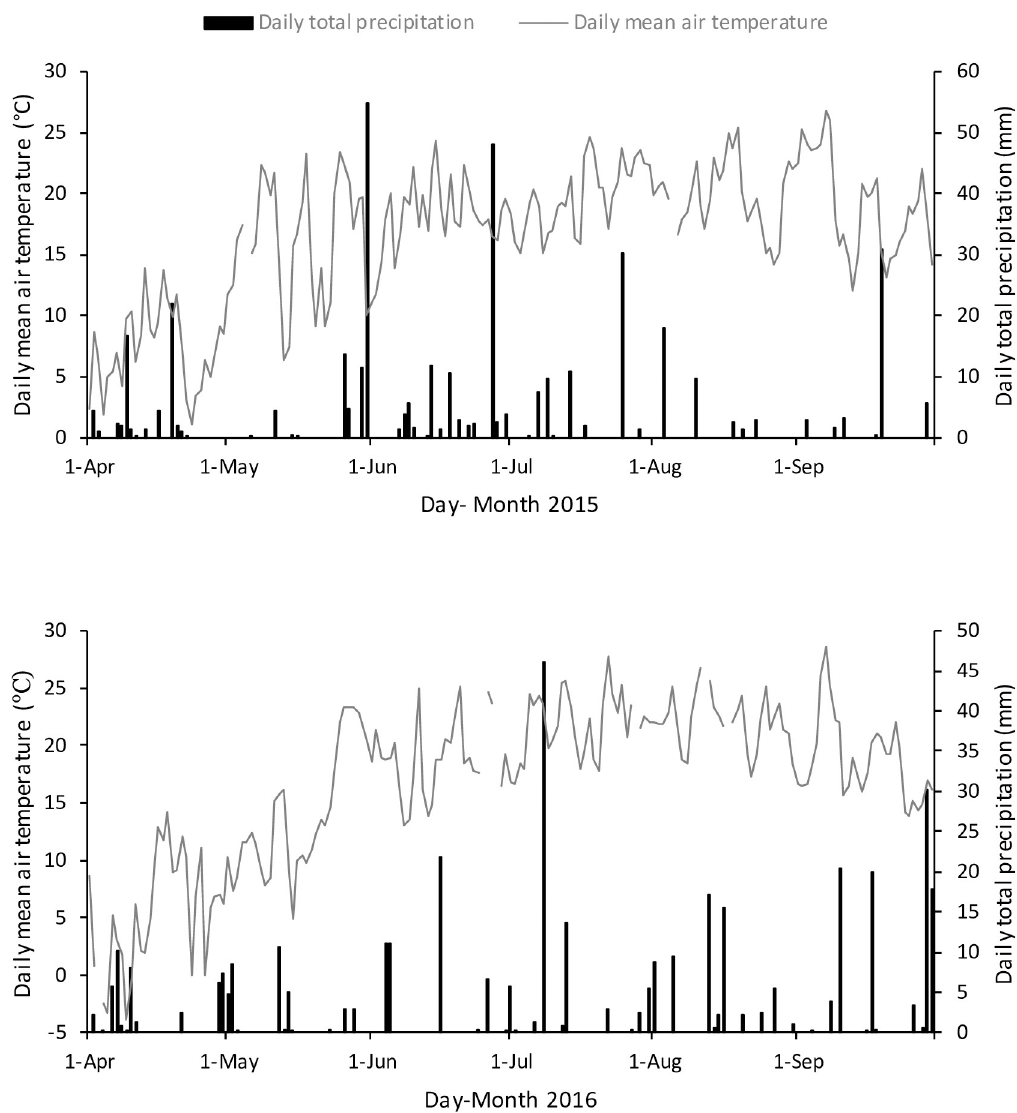
Fig 1. Daily total precipitation (mm) and mean air temperature (˚C) during the tomato growing season in 2015 and 2016 at Ridgetown, Ontario, Canada. Dash lines with arrows represent the soil sampling dates in site-year 2015 and